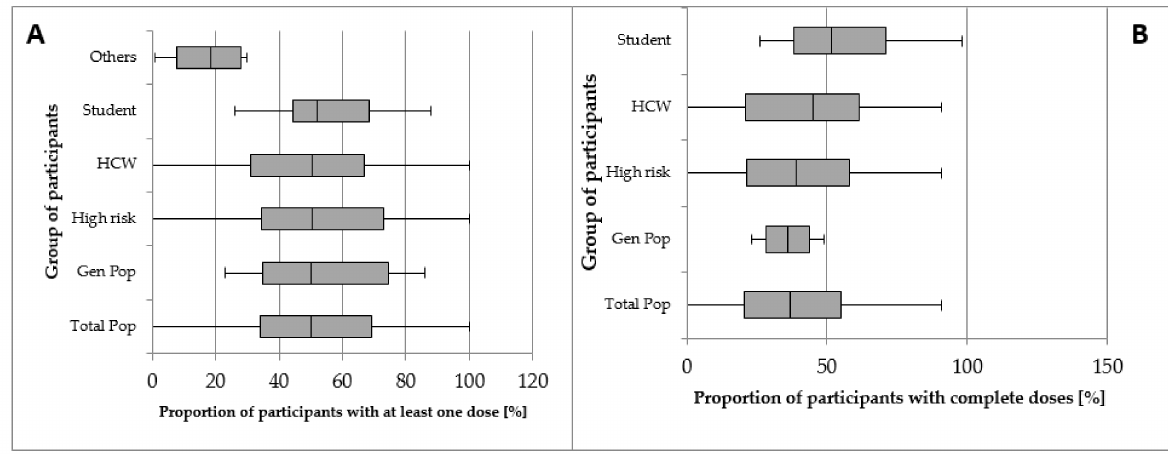
Figure 3. Proportion of participants with ( A ) at least one dose and ( B ) complete doses of hepatitis B